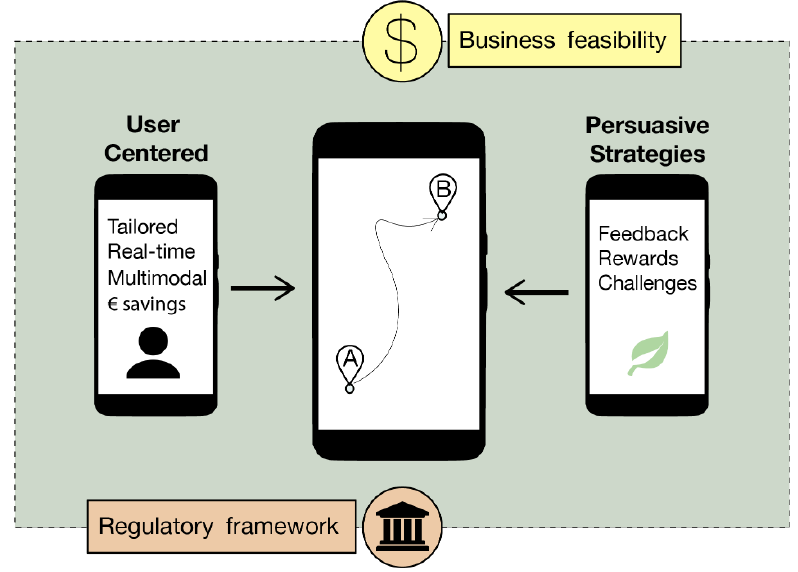
Figure 1. Mobility app design scheme.